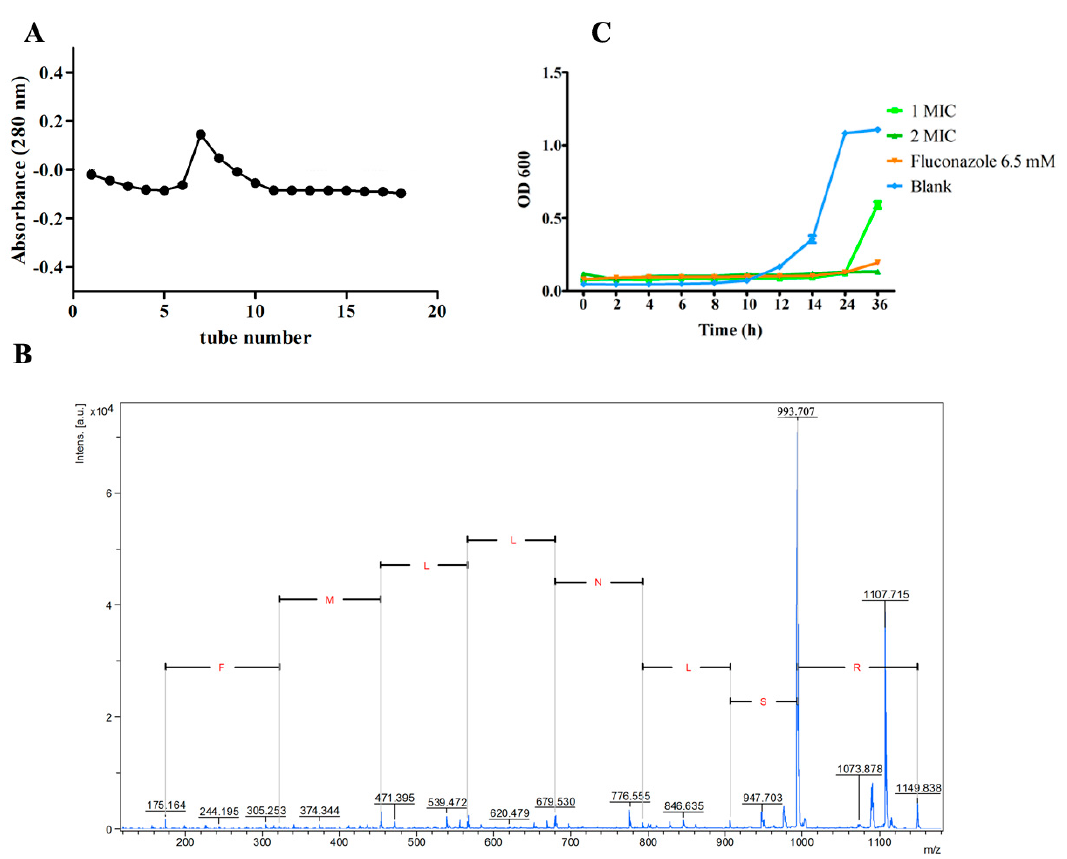
Figure 1. Isolation, identification, and antifungal activity of NpRS. ( A ) DEAE − fast flow chromatogra- phy elution curve of peptide fraction eluted with PBS for the unbounded fraction; ( B ) MALDI − TOF MS/MS spectra of NpRS; ( C ) Growth inhibition curve by different concentrations of NpRS. All data were expressed as the mean values of triplicate ± standard